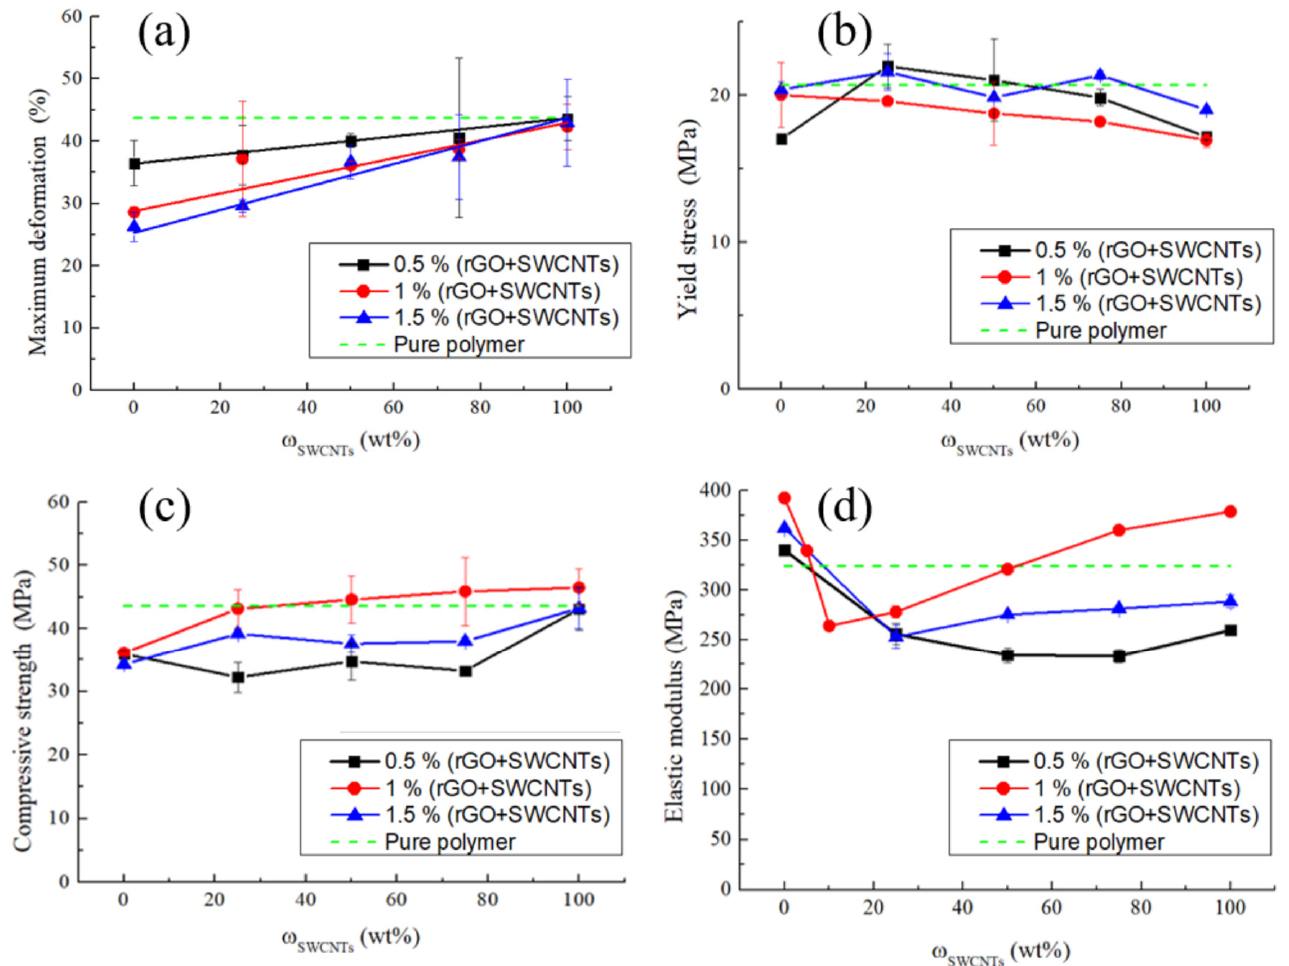
Figure 4. ( a ) Maximum deformation, ( b ) yield stress, ( c ) compressive strength, and ( d ) elastic modulus of obtained composites plotted against the mass content of SWCNTs in the rGO/SWCNTs